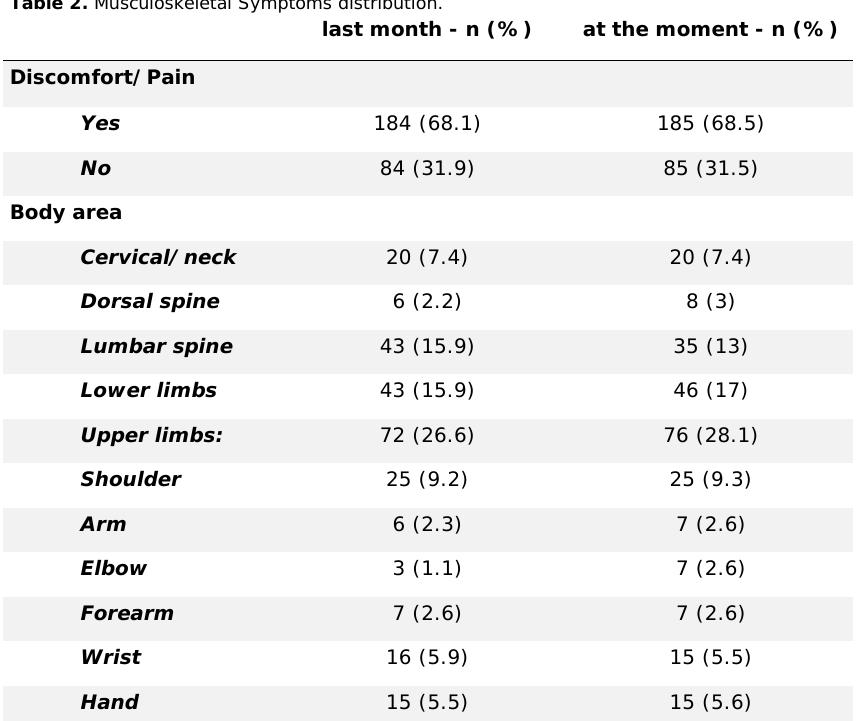
Table 2. Musculoskeletal Symptoms